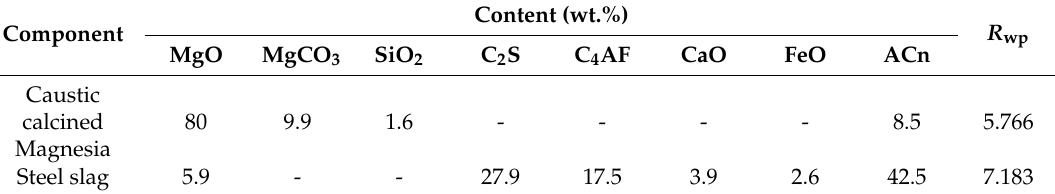
Table 2. Phase compositions of caustic calcined magnesia and steel slag. Component